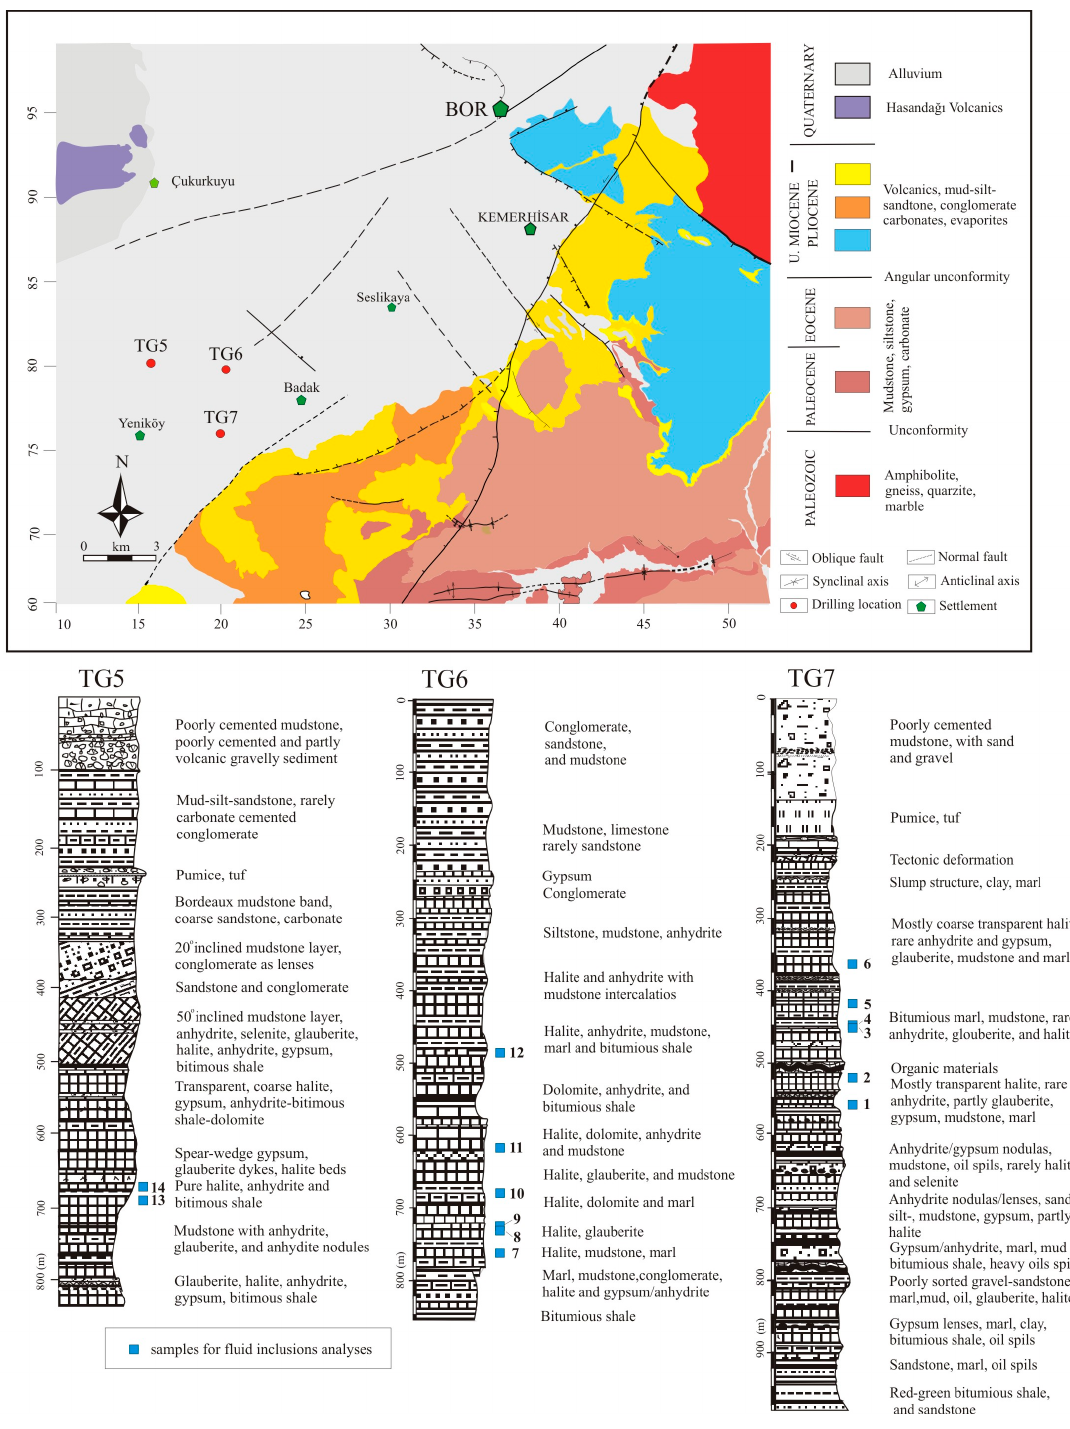
Figure 2. Lithological profiles and locations of TG-5, TG-6, and TG-7 boreholes on the geological map of the southern part of the Tuz Gölü Basin.